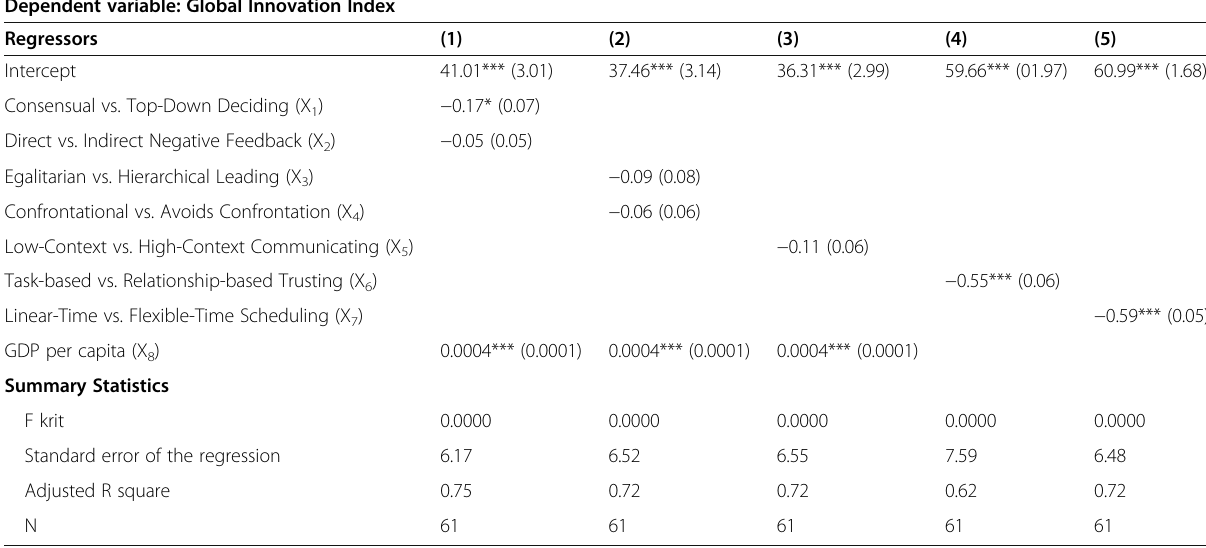
Table 2 Results of the regression analyses: The Culture Map to GII Dependent variable: Global Innovation